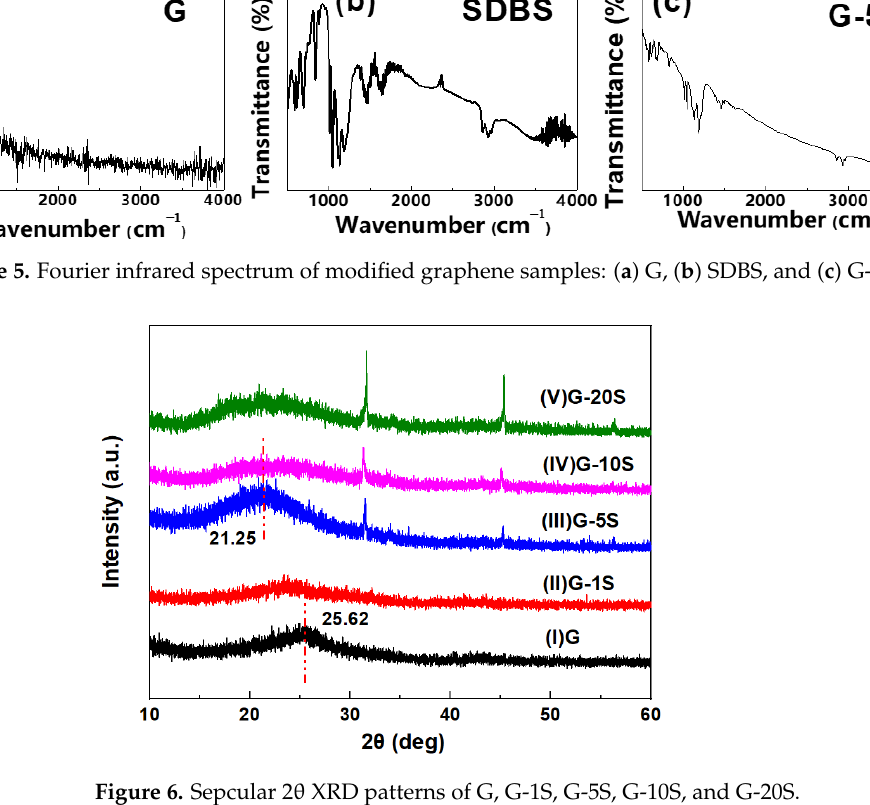
Figure 6. Sepcular 2θ XRD patterns of G, G -1S, G-5S, G-10S, and G-20S.